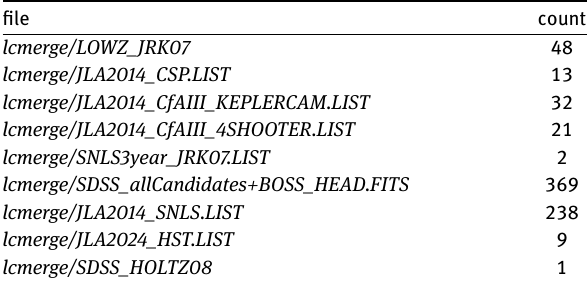
Table 1. Index source files for B14